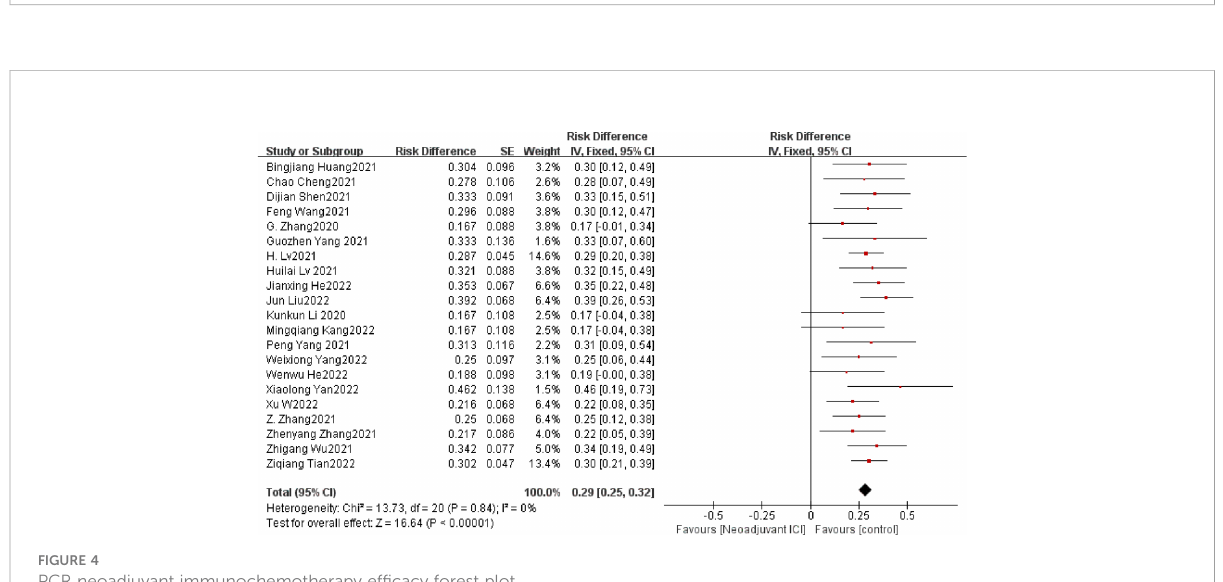
FIGURE 4 PCR neoadjuvant immunochemotherapy ef fi cacy forest